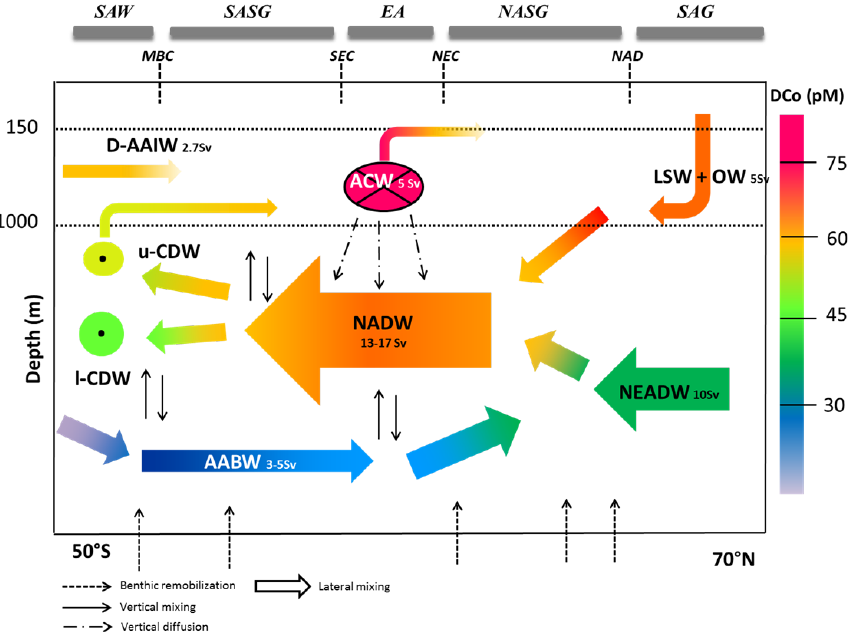
Fig. 7. Conceptual schema of the D Co transportation along the large-scale circulation in the intermediate and deep western Atlantic Ocean. Table 2. Averaged dissolved cobalt concentration ( D Co) and standard deviation (SD) obtained in the different water masses encountered along the western Atlantic GEOTRACES-A02 section: the Northeast Atlantic Deep Water (NEADW), Labrador Sea Water (LSW), North Atlantic Deep Water (NADW), Western Atlantic Central Waters (W-ACW), Northwest Antarctic Bottom Water (NW-AABW), Southwest Antarctic Bottom Water (SW-AABW), Upper Circumpolar Deep Water (UCDW) and Drake Antarctic Intermediate Water (D-AAIW). D Co (pM) Water mass D Co (pM) SD (pM) (Others) (This study) (This study) (This